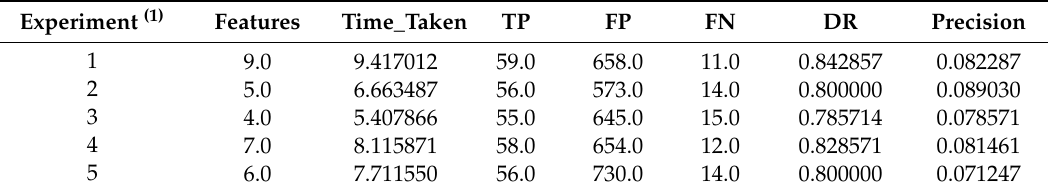
Table 7. LOF results with feature optimization. N_neighbours = 20 and contamination = 0.01. Experiment